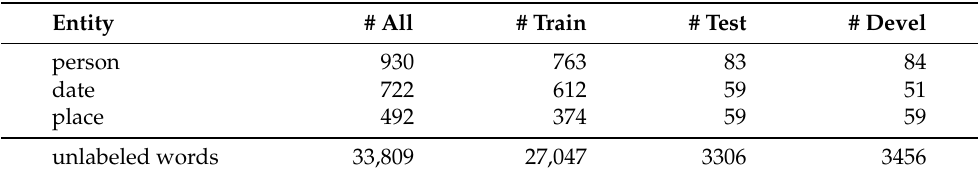
Table 2. Distribution of NER entities in the Sturm Edition. On average, an entity consists of 1.12